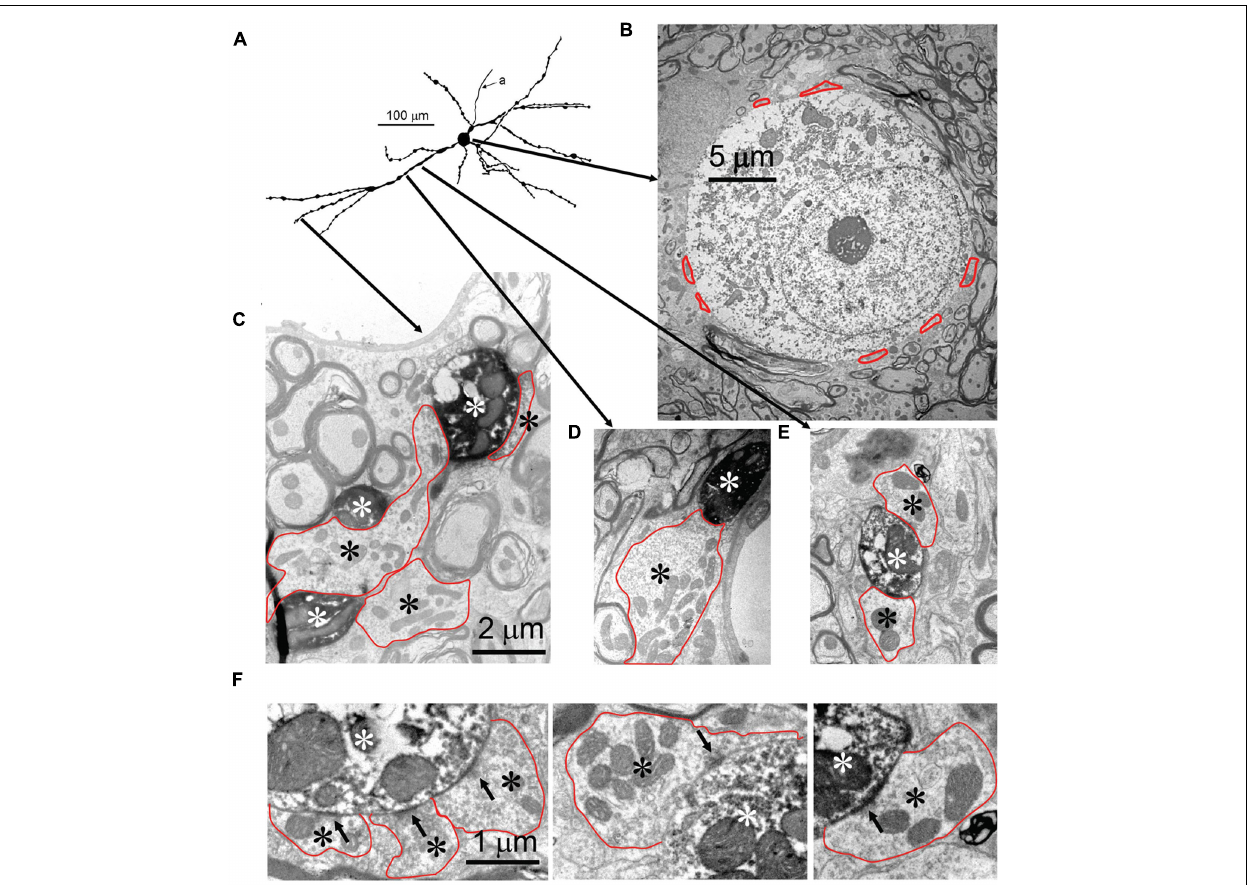
FIGURE 3 | Synaptic inputs to an mLNTB cell. (A) Camera lucida drawing of the mLNTB cell. CF = 990 Hz. For its location in the SOC: see Figure 1 . (B) Cell body. Red dotted outlines indicate synaptic terminals. (C–E) Electron micrographs illustrate the presence of large synaptic terminals (black asterisks, red outlines) on dendrites (white asterisks) at the location of the arrow origins shown in (A) . (F) Examples of synaptic specializations (arrows) at higher magnification seen in (C–F) or in adjacent sections.